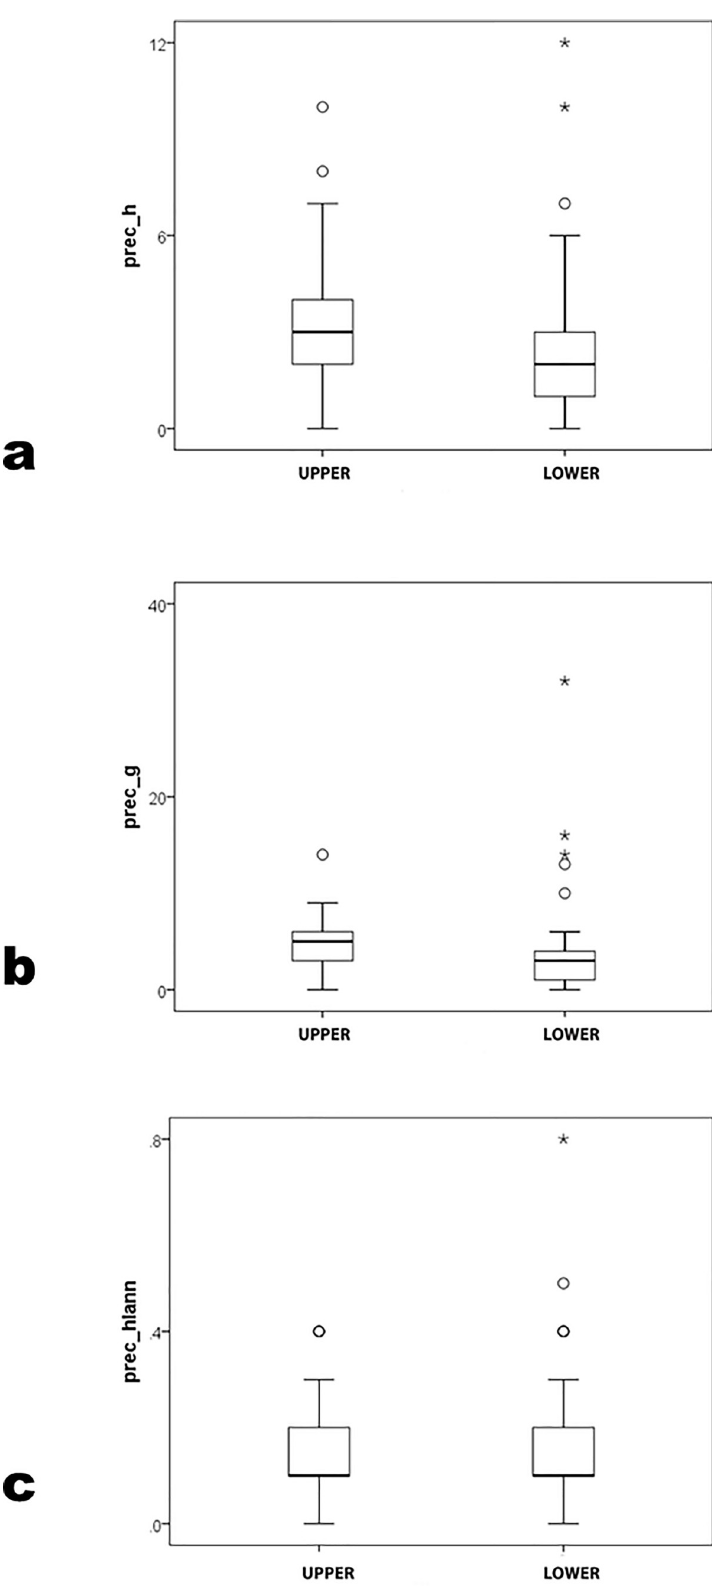
Fig 8. prec_ h , prec_ g and prec_ hIann by NRC-rank top and bottom halves. https://doi.org/10.1371/journal.pone.0259038.g008 PLOS ONE | https://doi.org/10.1371/journal.pone.0259038 January 31,